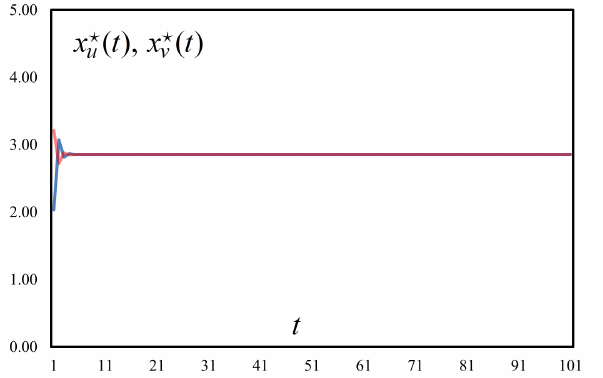
Figure 9. Convergence dynamics of Nash allocations ( x (cid:63) u , x (cid:63) v ) for α = 0.50 and φ = 0.80. The x -axis corresponds to the timeline ( t ). The y -axis denotes the evolution of Nash allocations as a function of time ( x (cid:63) u ( t ) , x (cid:63) v ( t )